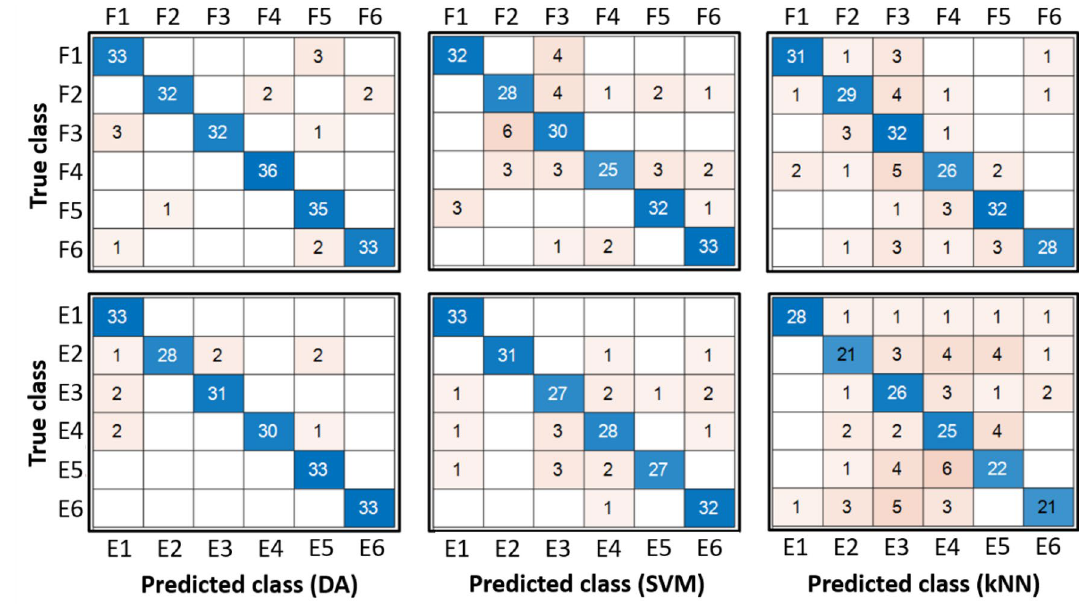
Figure 4. Confusion matrices were obtained in the multi-class classification problem for the flexion (F) and extension (E) tasks. Flexion (upper panel) and extension (lower panel) gestures were analyzed separately. From left to right, DA, SVM, and kNN results are shown. The average accuracy value for each of them is as follows: Flexion: 93% for DA, 83% for SVM, 82% for kNN; Extension: 95% for DA, 90% for SVM, 72% for kNN. Figure created with MatLab2020a and Microsoft PowerPoint